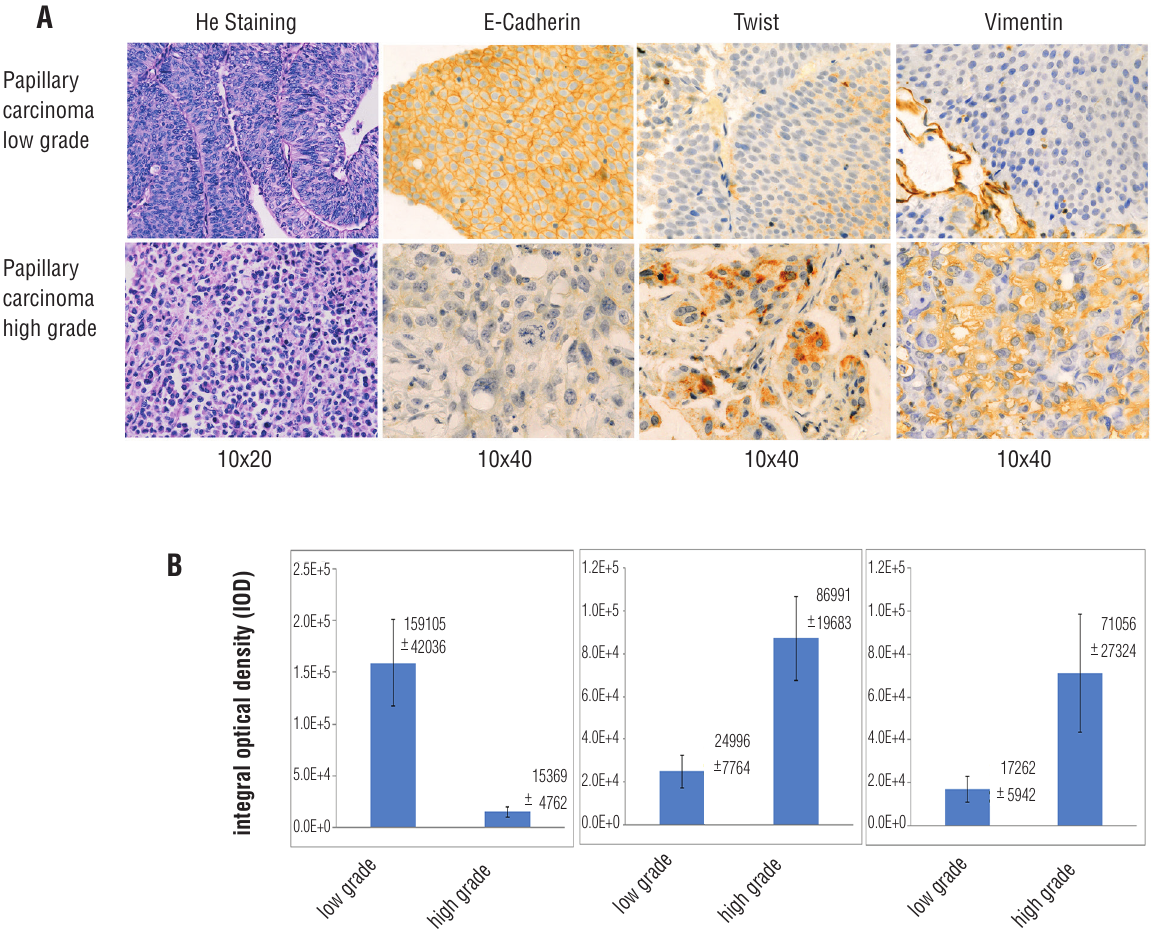
Figure 1 - E-cadherin, Twist and Vimentin expression in bladder cancer. A. Images of immunohistochemically detected expression. B. Bar graph of the values of the integrated optical density of E-cadherin, Twist and Vimentin in low and high grade papillary carcinoma. Results are expressed as the mean ±